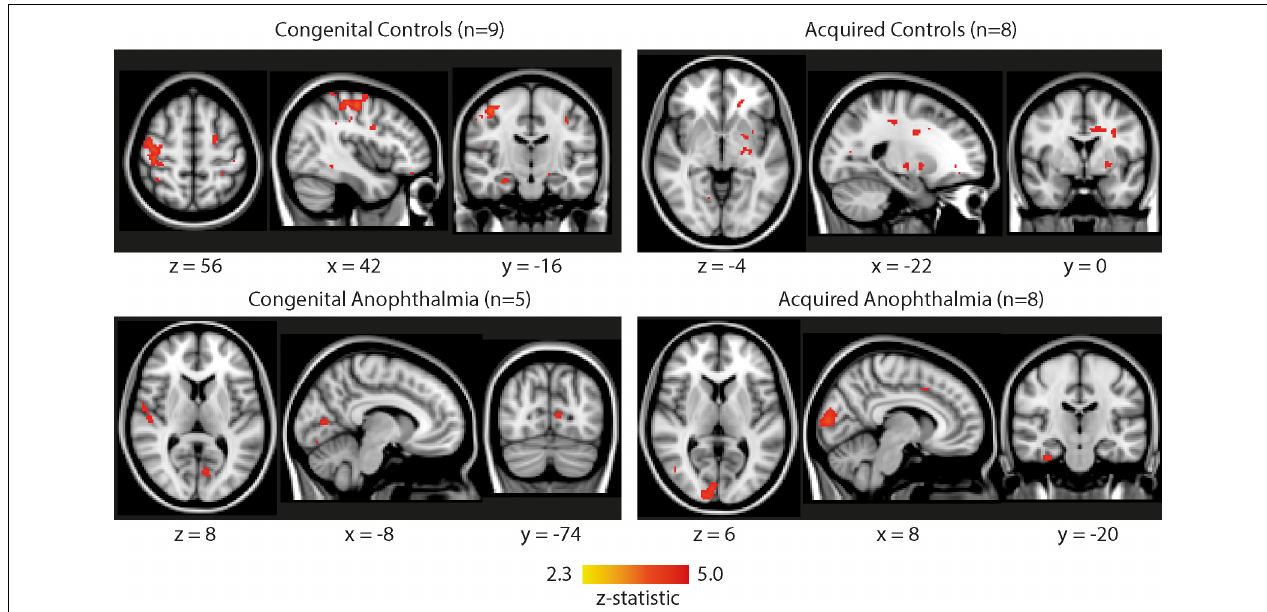
FIGURE 1 | Whole-brain functional activation pooled across all light conditions (ear, head, knee) for each subject group (congenital controls, acquired controls, congenital anophthalmia, acquired anophthalmia). For visualization purposes, statistical maps are thresholded at Z > 2.3 (uncorrected) and overlaid on MNI standard brain using FSLview. No results survive cluster